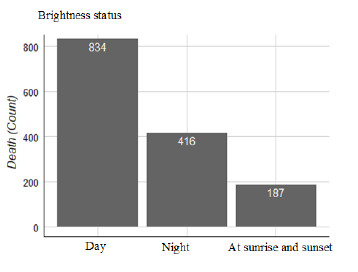
Figure 3. The mortality of road traffic accidents according to the brightness status during 2011-2015.